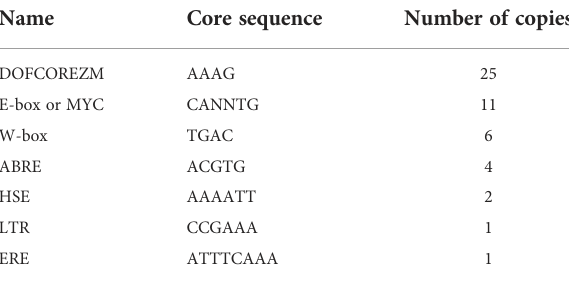
TABLE 1 Predicted cis - acting elements in the BplMYB46